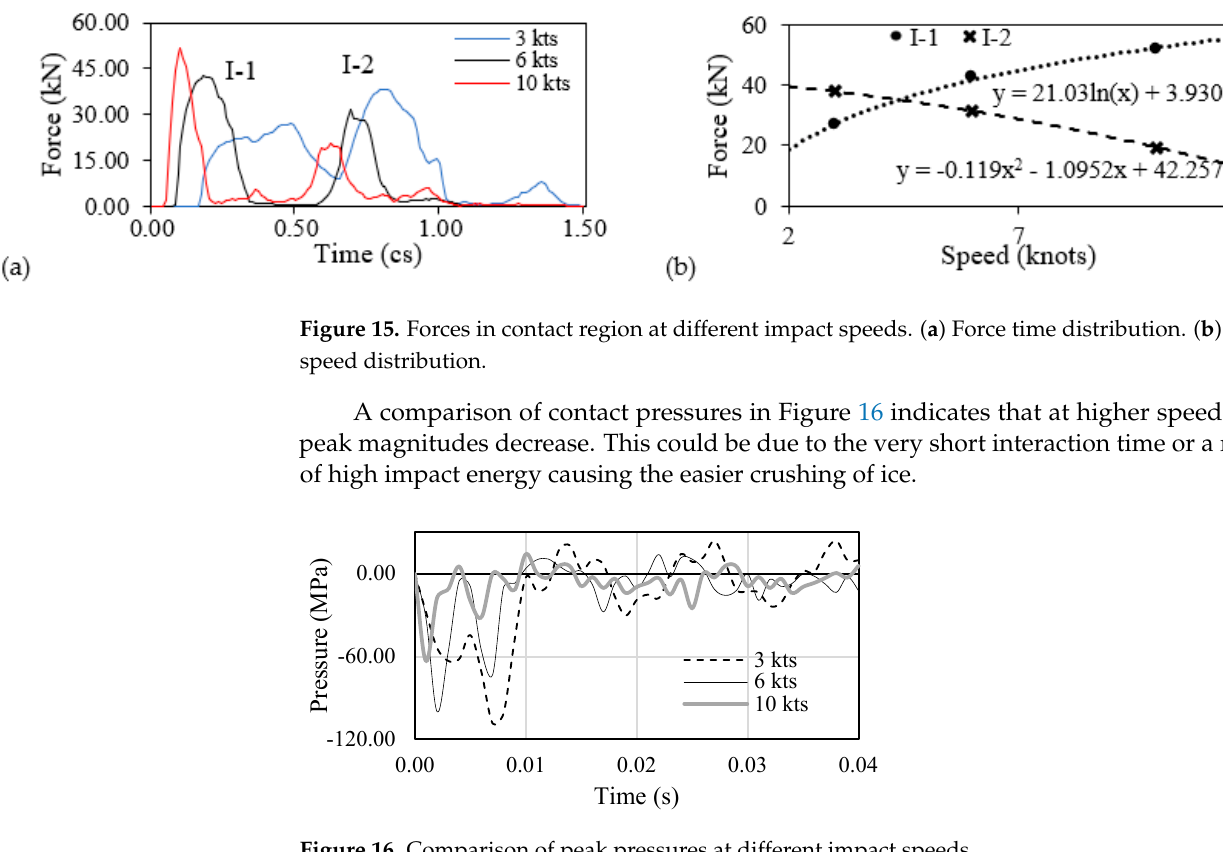
Figure 16. Comparison of peak pressures at different impact speeds.